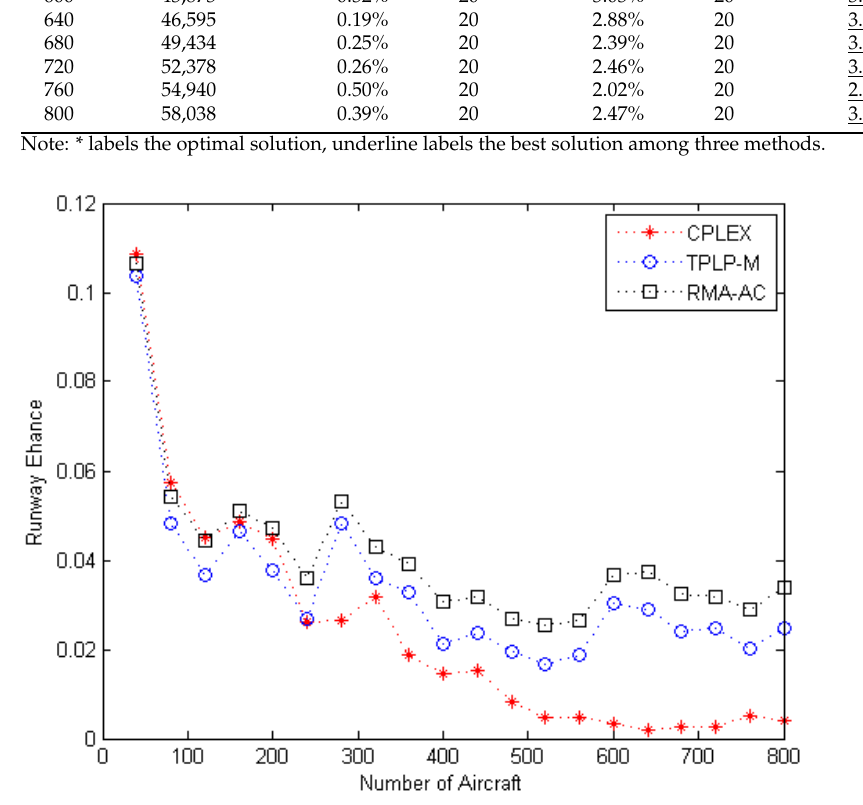
Figure 6. A comparison of the solution by the three methods for the random